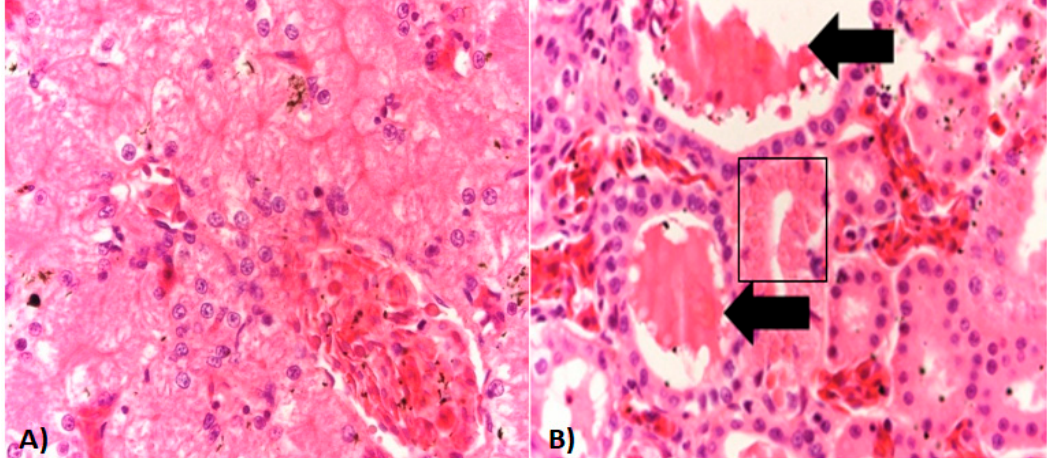
Figure 3. Histopathology of ranavirus-infected American bullfrogs. ( A ) Liver section from an affected bullfrog with mild congestion of sinusoids. ( B ) Kidney section shows an area of mild tubular necrosis characterized by cytoplasmic hyper-eosinophilia, loss of nuclei, and mild nuclear pyknosis (black square). Intraluminal protein casts are also seen (black arrows). Hematoxylin/Eosin staining. Magnification for all photos 20×/100 µm.